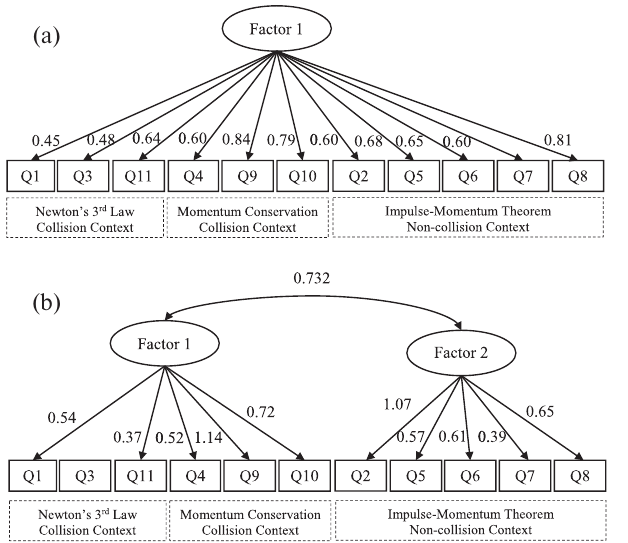
FIG. 7. Factor loadings for EFA of Chinese students ’ post-test with (a) one factor and (b) two factors.